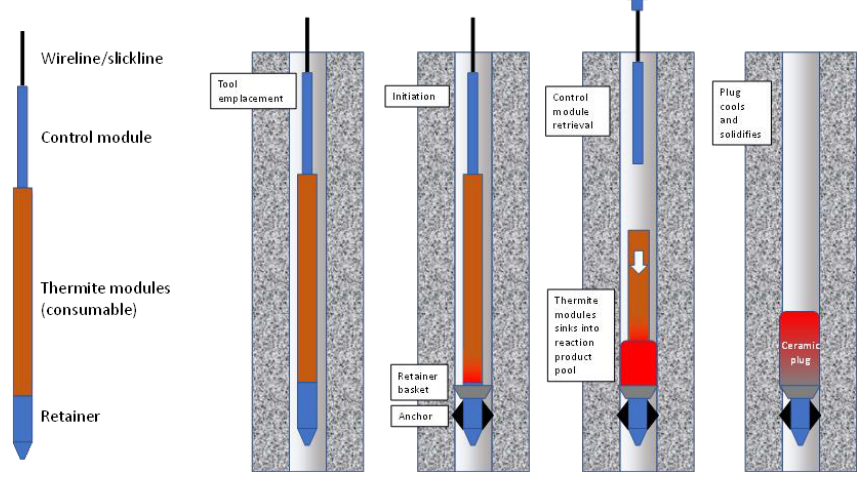
Figure 2. Thermite-only plug emplacement process, leaving the ceramic product in place. In Figure 3 the integration of thermite heater and fusible metal alloy is depicted. The thermite is housed in a non-consumed housing. When initiated the thermite module remains in place during reaction while metal alloy beads are released from the alloy housing above, surrounding the heater elements. The alloy melts to fill the tubing and at a prescribed time the retrievable parts of the toolstring (control module, alloy housing, and thermite modules) are pulled to the surface.